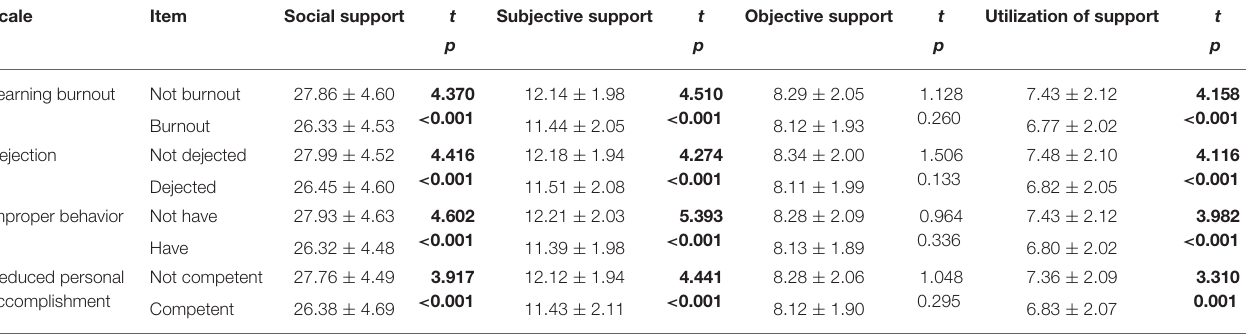
TABLE 3 | Differences in students’ SSRS and its dimensions’ scores by learning burnout, dejection, improper behavior, and reduced personal accomplishment groups.